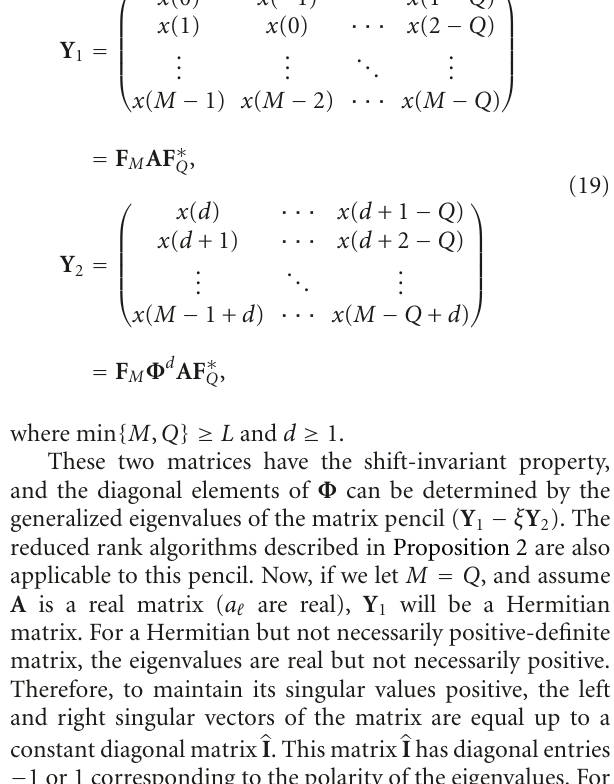
( F T ) ∗ : (a) magnitude of correlation coe ffi cients for a fixed Q = 50; (b) magnitude of the elements Q Q − ω (cid:2) 2 . 1